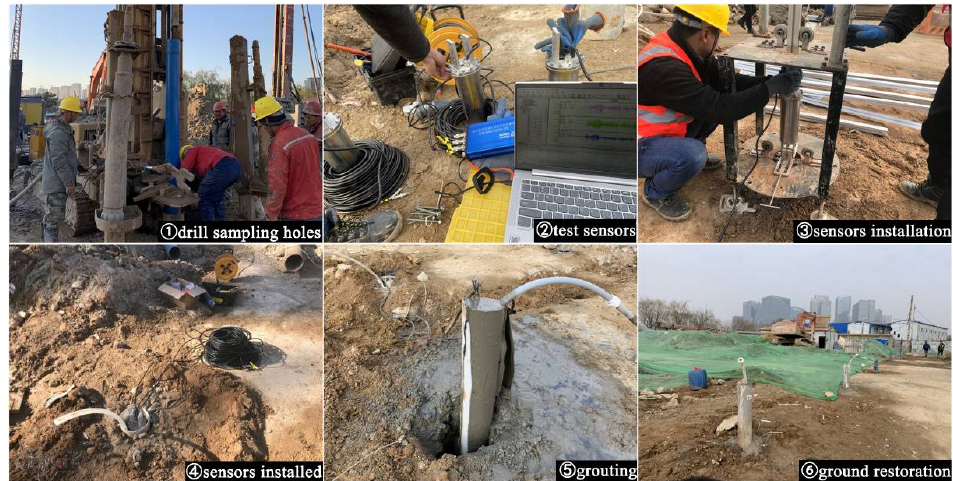
Figure 6. Installation process of the sensors.